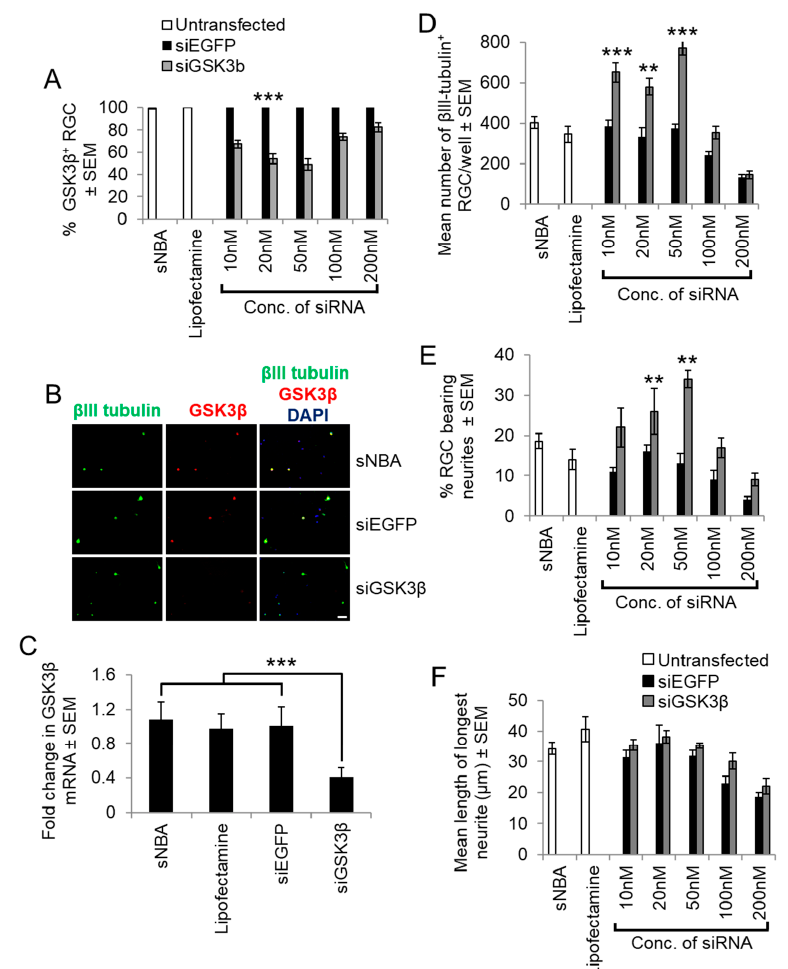
Figure 4. siGSK3 β -mediated knockdown in retinal cultures prepared from adult rats at five days after ONC. ( A ) Quantification of the proportion of GSK3 β + RGC with increasing concentrations of siGSK3 β when compared to sNBA and Lipofectamine 2000-treated controls. ( B ) Representative retinal cultures established five days after ONC in vivo to activate retinal glia and treated with siGSK3 β (50 nM) demonstrated a lack of GSK3 β (red) detection in β III-tubulin + RGC (green), whilst abundant immunoreactivity was present in β III-tubulin + RGC in sNBA and siEGFP-treated (50 nM) control cultures. (Scale bar in B = 20 µm; ** = p < 0.01; *** = p < 0.001). ( C ) Analysis of GSK3 β mRNA levels in cultured adult rat retinal cells after transfection with the optimal concentration of siGSK3 β (50 nM) to confirm GSK3 β knockdown. (*** = p < 0.001). ( D ) Quantification of the proportion of surviving β III-tubulin + RGC with increasing concentrations of siGSK3 β shows that 50 nM optimally promotes RGC survival. ( E ) Quantification of the proportion of RGC bearing neurites with increasing concentrations of siGSK3 β shows that 50 nM was optimal to stimulate initiation of neurite outgrowth. ( F ) Quantification of the longest RGC neurite length shows that increasing concentrations of siGSK3 β does not affect the length. (** = p < 0.01; *** = p < 0.001). n = 2 wells/treatment, 3 independent repeats (total n = 6 wells/treatment).